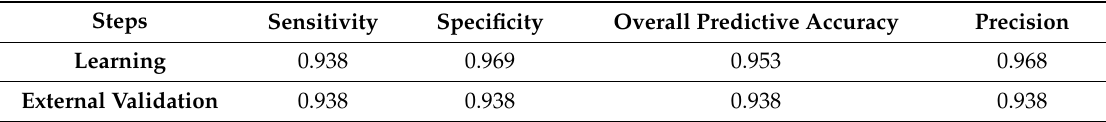
Table 3. Performance of the P-gp modulator / non-modulator prediction model based on the RF classifier algorithm.